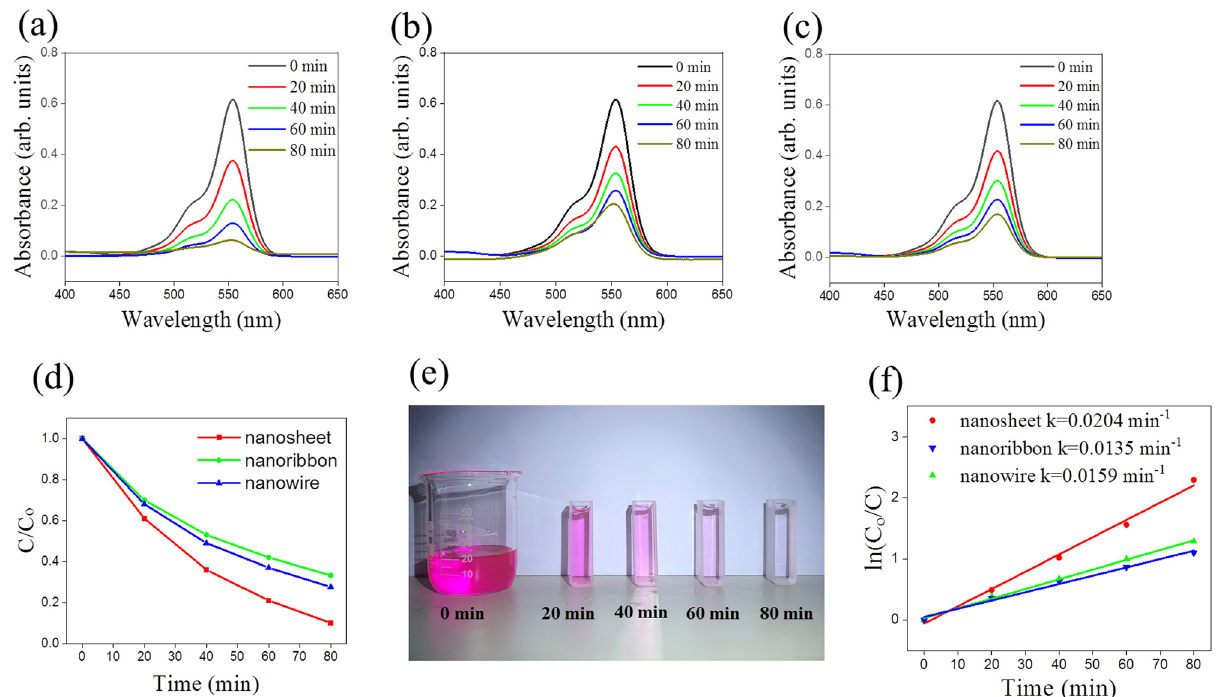
Figure 9: The irradiation – duration - dependent absorption intensity variation of the RhB solution with various Bi 2 S 3 photocatalysts at 1 V: ( a ) nanosheet, ( b ) nanoribbon, and ( c ) nanowire. ( d ) C / C o versus irradiation duration plot with various Bi 2 S 3 photocatalysts at 1 V. ( e ) Decoloration of RhB solution with Bi 2 S 3 nanosheets after di ff erent PEC - degradation durations. ( f ) ln ( C o / C ) versus irradiation duration plot with various Bi 2 S 3 photocatalysts at 1